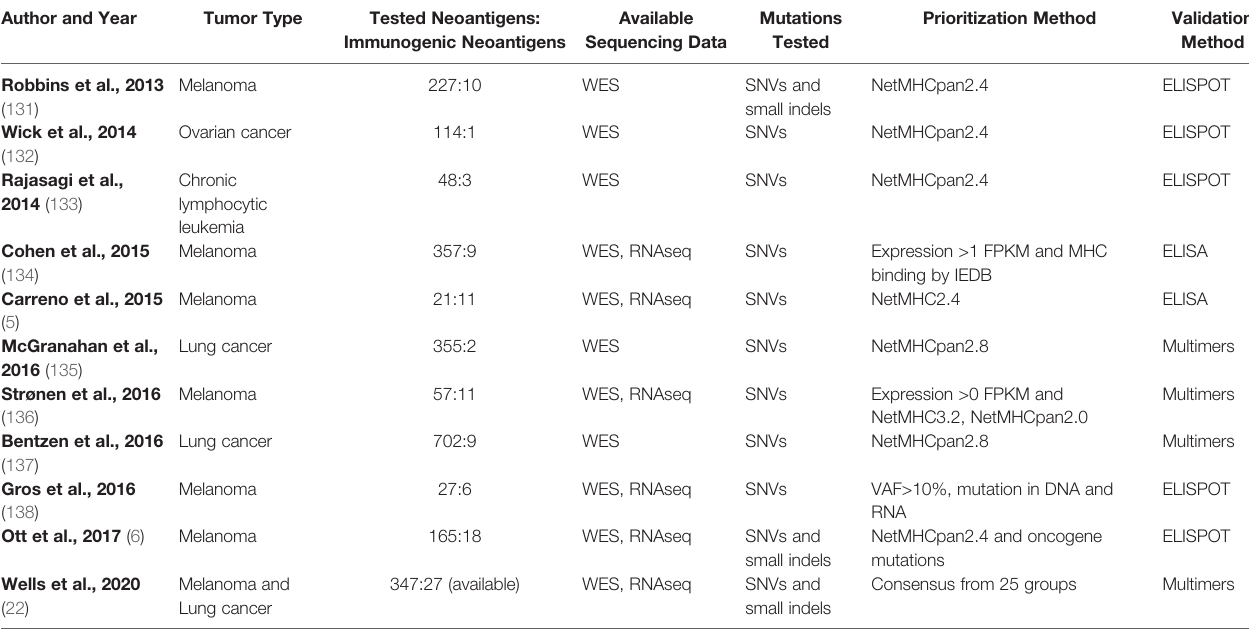
TABLE 7 | Available sets of MHC class I-restricted neoantigens validated to elicit a CD8+ T cell